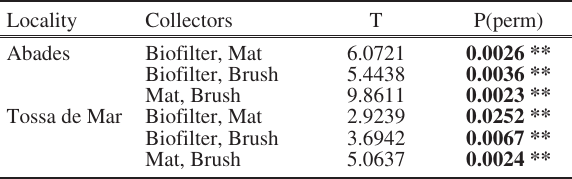
Table S2. – Pairwise comparisons for the significant interaction of the factors ‘Collector × Locality’ obtained in the permutational analysis of variance (PERMANOVA) assessing differences in num- ber of P. lividus settlers per unit area. Differences in settlers/m 2 den- sities at Abades (during February 2012) and at Tossa de Mar (during June 2012) among the three kinds of artificial collector tested are